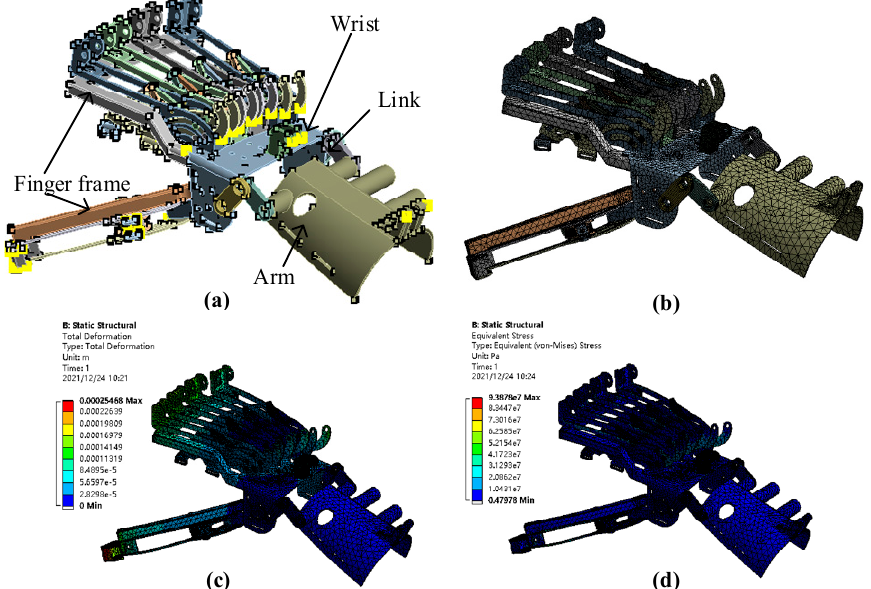
Figure 11. ( a ) Simplified model; ( b ) finite element model; ( c ) deformation cloud; ( d ) stress cloud.